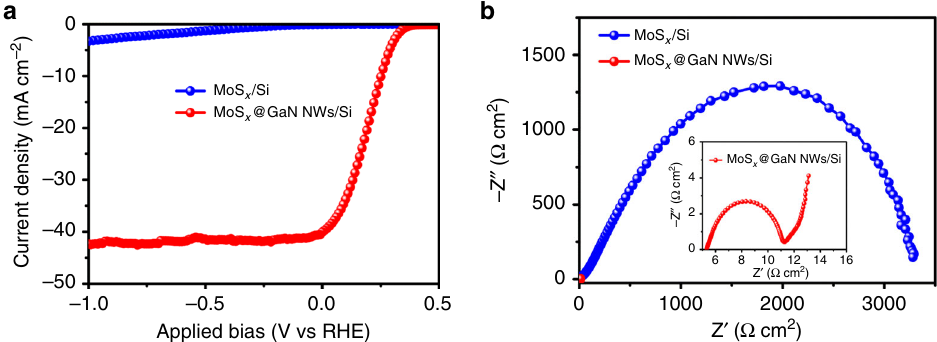
Fig. 5 The function of GaN nanowire. a J – E curves of MoS x /Si and MoS x @GaN NWs/Si in 0.5 M H 2 SO 4 under standard one-sun illumination. b Electrochemical impedance spectroscopy (EIS) analysis of MoS x /Si and MoS x @GaN NWs/ Si. Inset graph is the magni fi cation of EIS of MoS x @GaN